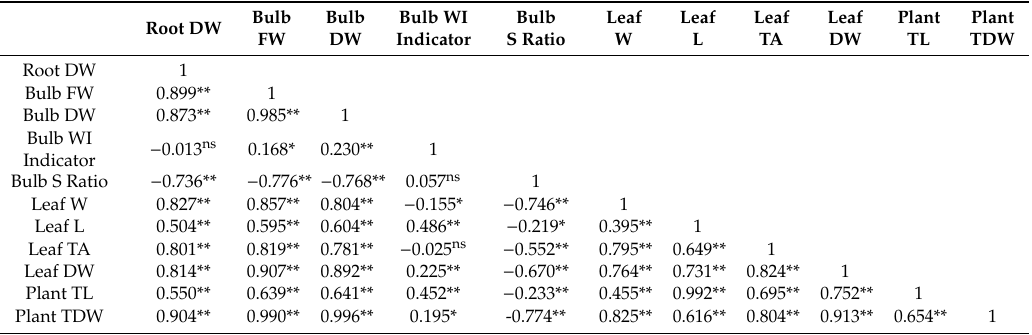
Figure 5. Effect of size group and lifting term on root DW (g plant −1 ) for Lednice (LE) and Krakow Figure 5. E ff ect of size group and lifting term on root DW (g plant − 1 ) for Lednice (LE) and Krakow (KR) locations. Mean values with different small letter within the location (LE or KR) as well as mean (KR) locations. Mean values with di ff erent small letter within the location (LE or KR) as well as mean values with different large letter are significantly different according to Duncan’s multiple range test values with di ff erent large letter are significantly di ff erent according to Duncan’s multiple range test at at p ≤ 0.05. For treatments description, see 2.1.–2.4, Materials and Methods sections. p ≤ 0.05. For treatments description, see Sections 2.1–2.4, Materials and Methods sections. Table 3. Pearson’s correlation coe ffi cients among all studied Table 3. Pearson’s correlation coefficients among all studied parameters.